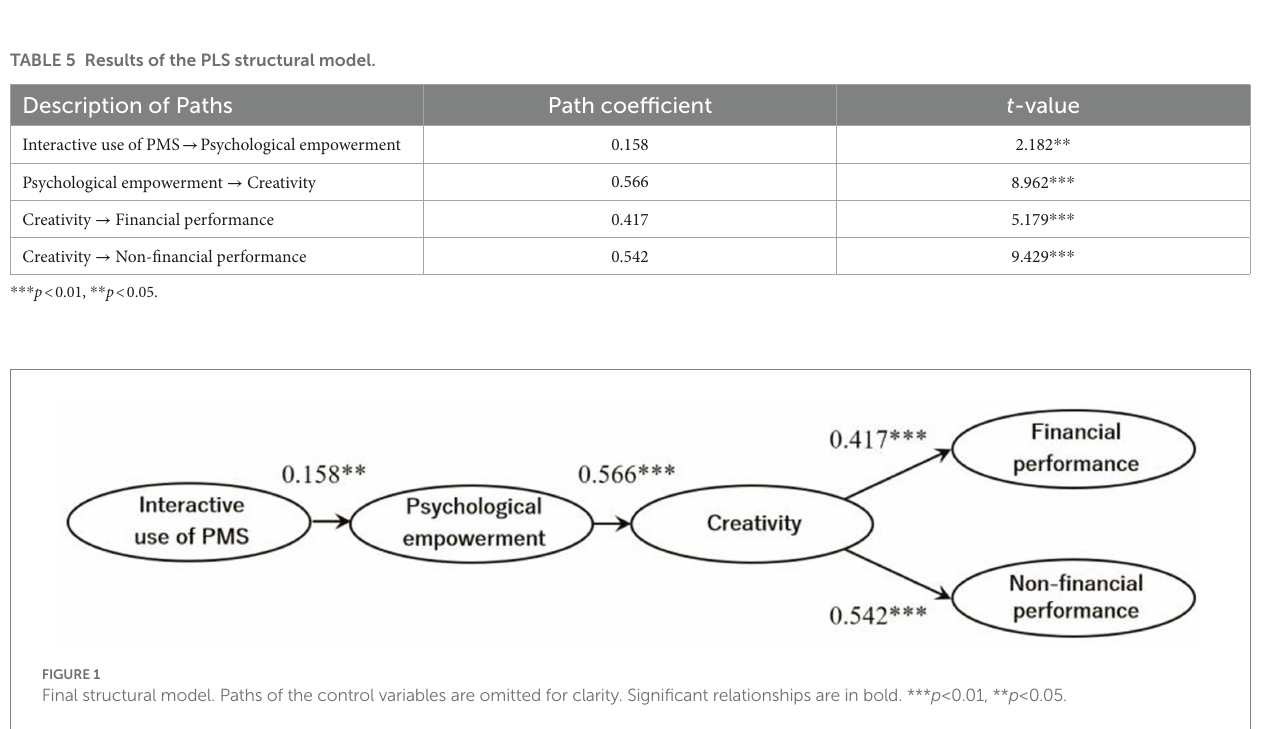
effect size in relation to the total effect (i.e., direct effect + indirect